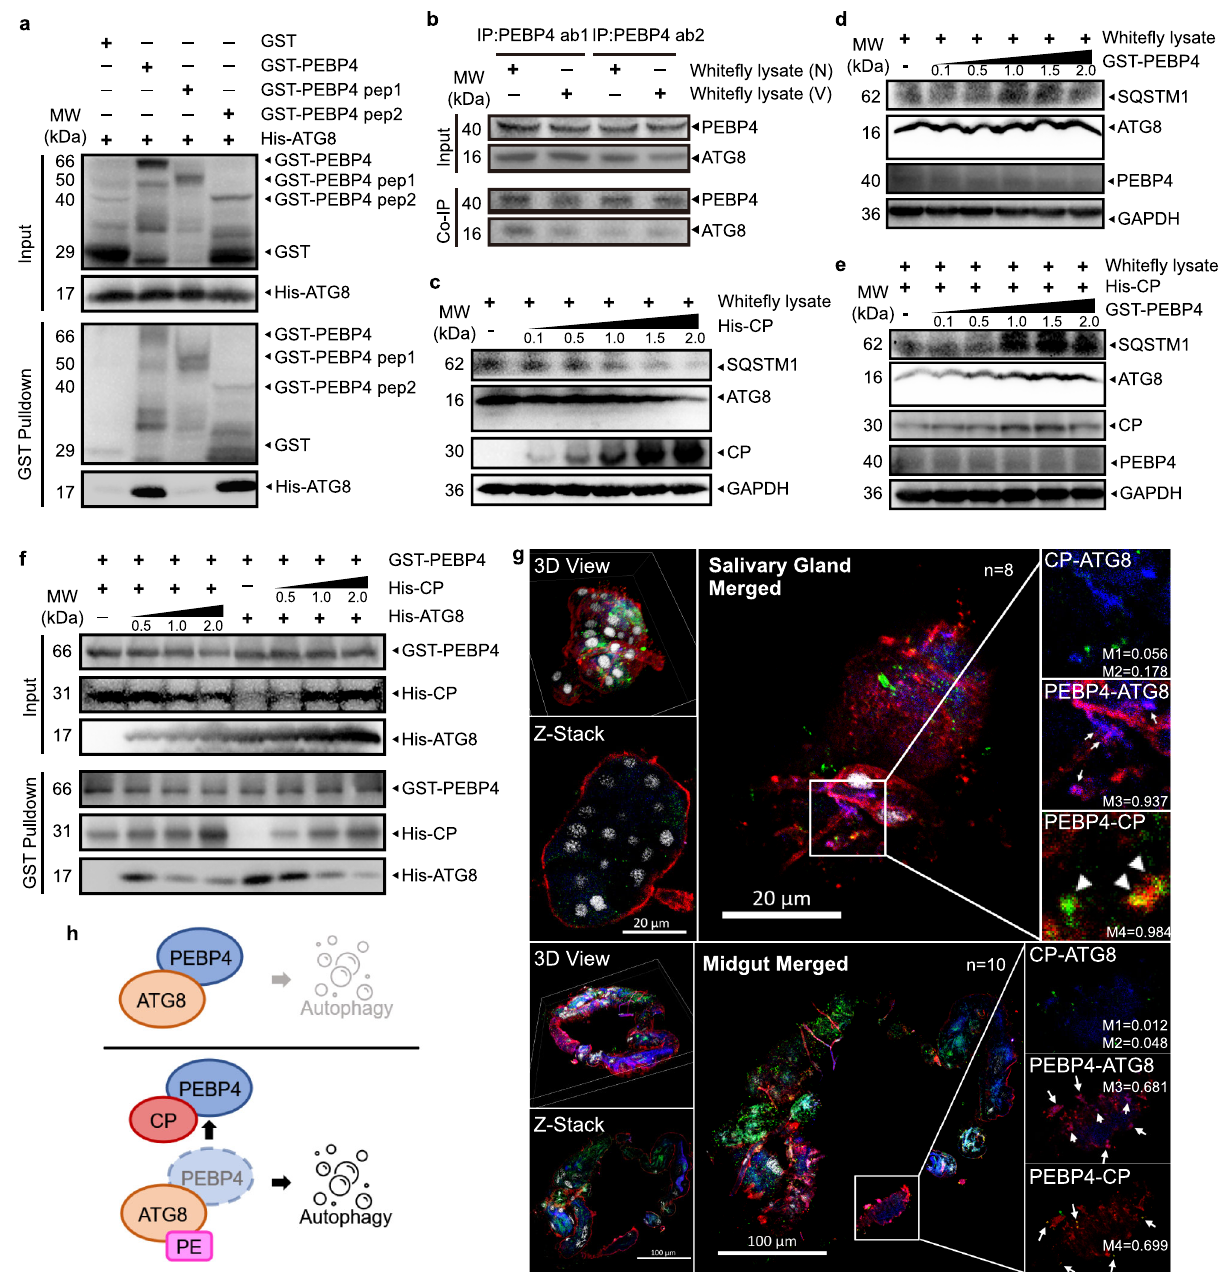
Fig. 5 CP competitively interacted with PEBP4 to liberate ATG8 and promoted autophagy. a GST pull-down showing the interaction between recombinant His-ATG8 and GST-PEBP4. b PEBP4 co-immunoprecipitated with ATG8 in viruliferous (V) or nonviruliferous (N) white fl y. c – e Recombinant His-CP and GST-PEBP4 with concentration gradients were co-incubated with the lysate of white fl y to monitor the activation of autophagy by immunoblotting, PEBP4 bands represent endogenous abundance. f Competition between CP and ATG8 for PEPB4 by competitive pull-down assays. His-CP and His-ATG8 were supplied within a concentration gradient to co-incubate with GST-PEBP4. g ATG8 (blue), PEBP4 (red), and CP (green) were simultaneously labeled and localized by immuno fl uorescence in viruliferous white fl y. The nuclei were stained by DAPI (white). Sample sizes ( n ) for statistical tests indicated in the panels refer to biologically independent white fl y. Colocalization was quanti fi ed by ImageJ Coloc2 using Manders ’ Colocalization Coef fi cients (MCC). M1 = CP-ATG8/Total ATG8; M2 = CP-ATG8/Total CP; M3 = PEBP4-ATG8/Total ATG8; M4 = CP-PEBP4/Toal CP. h Model of CP-PEBP4 regulated autophagy in white fl y. Unconjugated ATG8 arrested PEBP4 to prevent autophagy in nonviruliferous white fl y. Upon TYLCV invasion, CP competed for PEBP4 binding, which released ATG8 and initiated